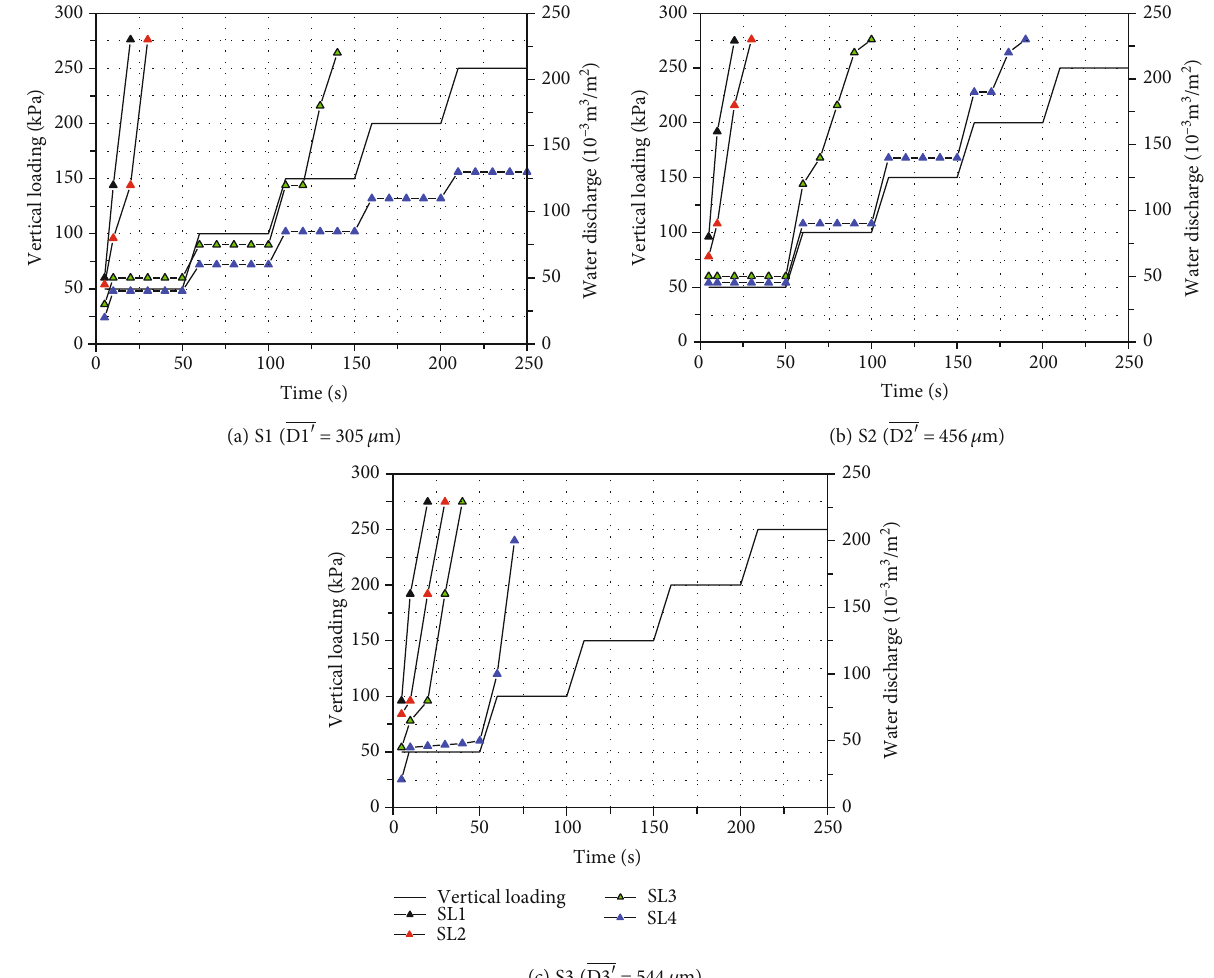
Figure 2: Pressure gradient and in fi ltration curve of the